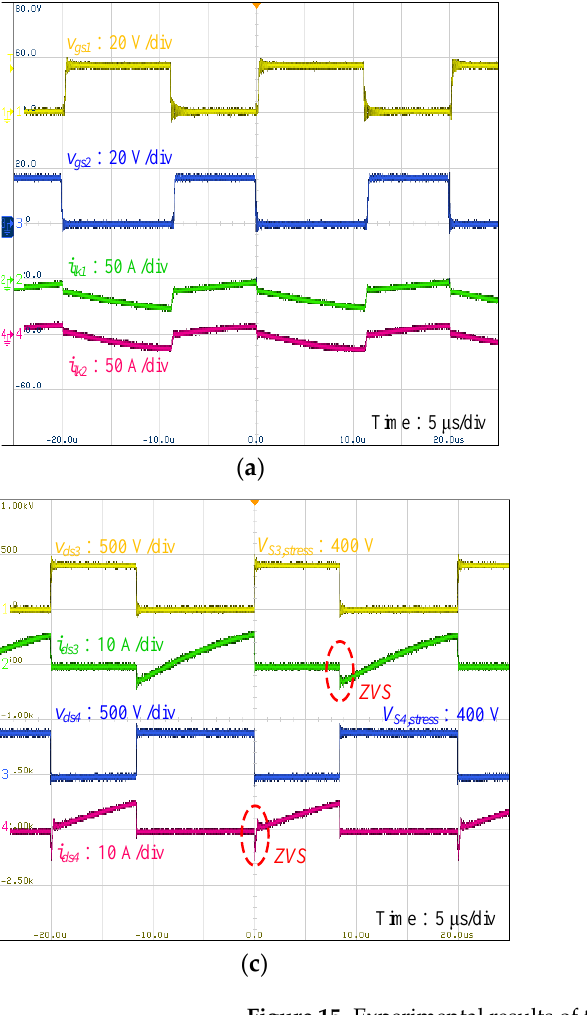
Figure 16. Measured waveforms of load variation of the proposed topology: ( a ) step-up mode, and ( b ) step-down mode.